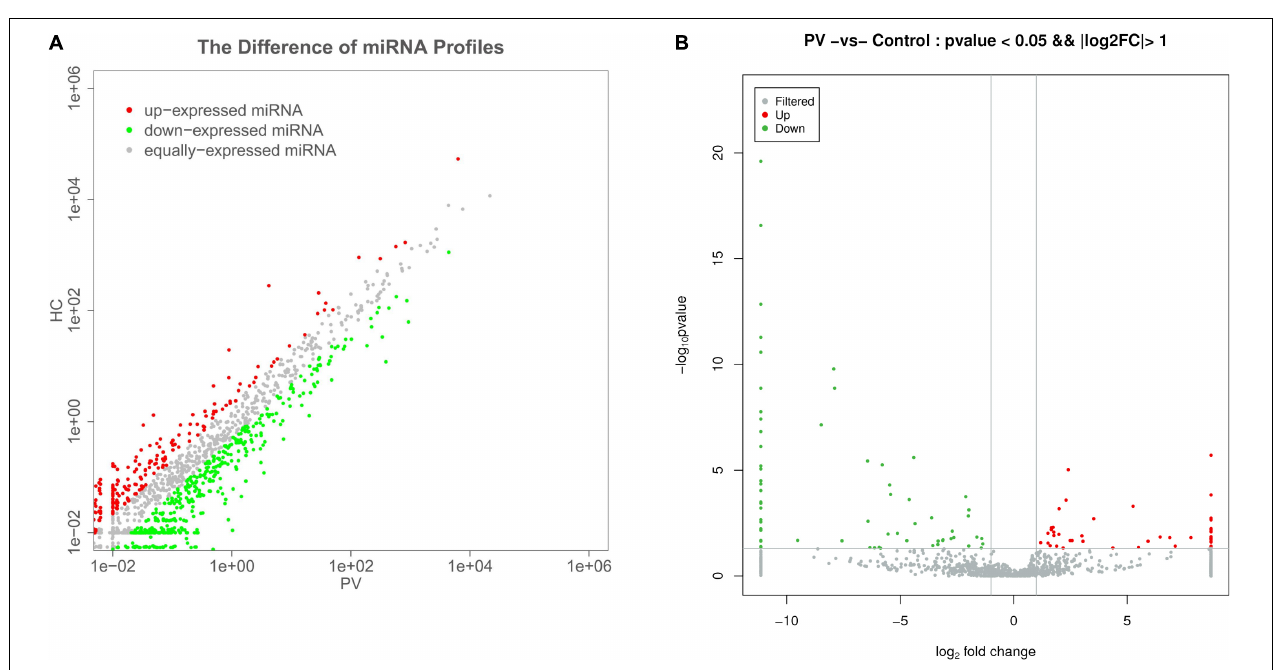
FIGURE 2 | Characteristics of miRNA levels between control group and PV group. (A,B) All miRNA levels are shown, and miRNAs with differentially levels are shown in red (up-regulated) or green (down-regulated).